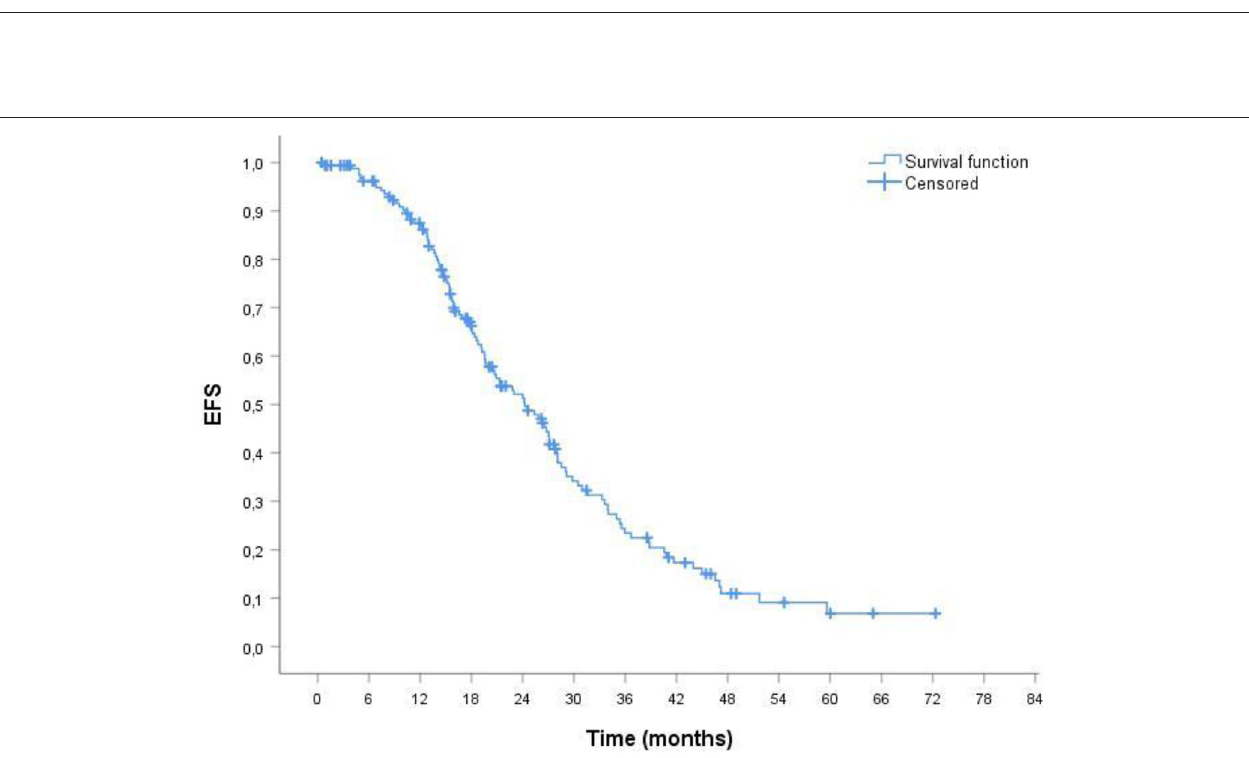
FIGURE 2 | Probability of event-free survival (EFS) by Kaplan-Meier estimates in patients with MM treated with VMP (total patients 164). The median EFS was 18.51 mo. VMP, bortezomib plus melphalan-prednisone.